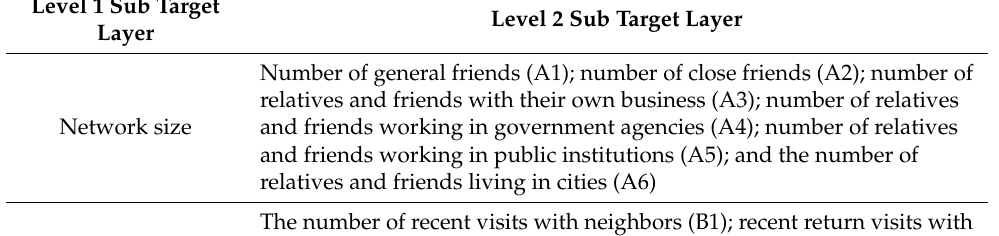
Table 1. Evaluation System of farmers’ social network